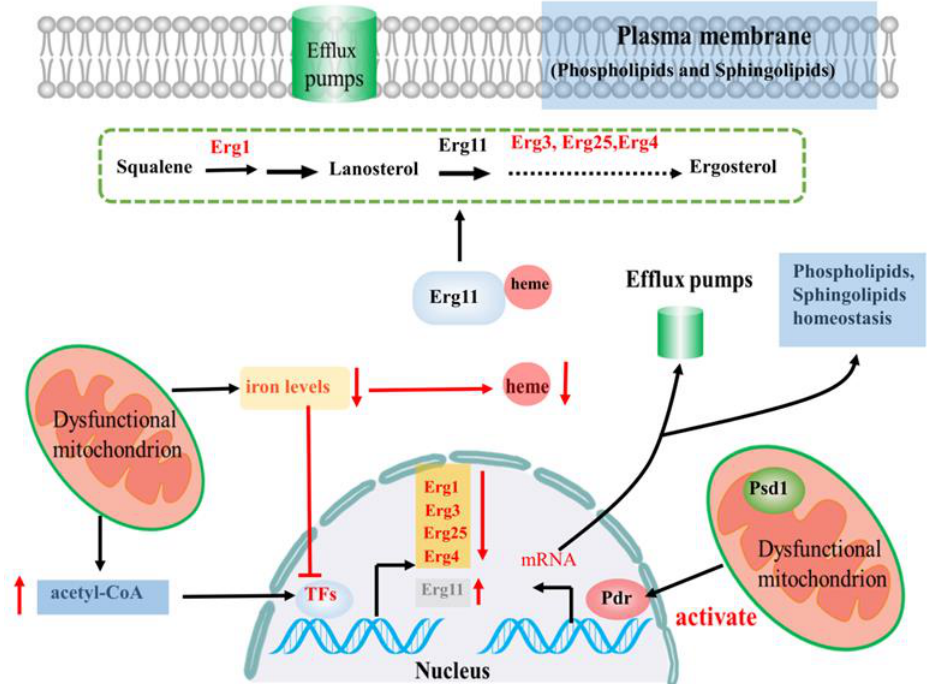
Figure 3. Linking fungal lipid biosynthesis and mitochondrial function in azole drug resistance: mitochondrial dysfunction leads to deregulation of iron metabolism and disturbs ergosterol biosynthesis, causing increased azole susceptibility. On the one hand, the disorder of iron metabolism leads to the deregulation of ergosterol biosynthesis gene expression ( Erg1, Erg3, Erg25 , and Erg4 ), with a commensurate decrease in ergosterol levels. On the other hand, the deregulation of iron metabolism also contributes to a decrease in ergosterol levels by decreasing heme levels. mitochondrial dysfunction due to mutated cofilin.